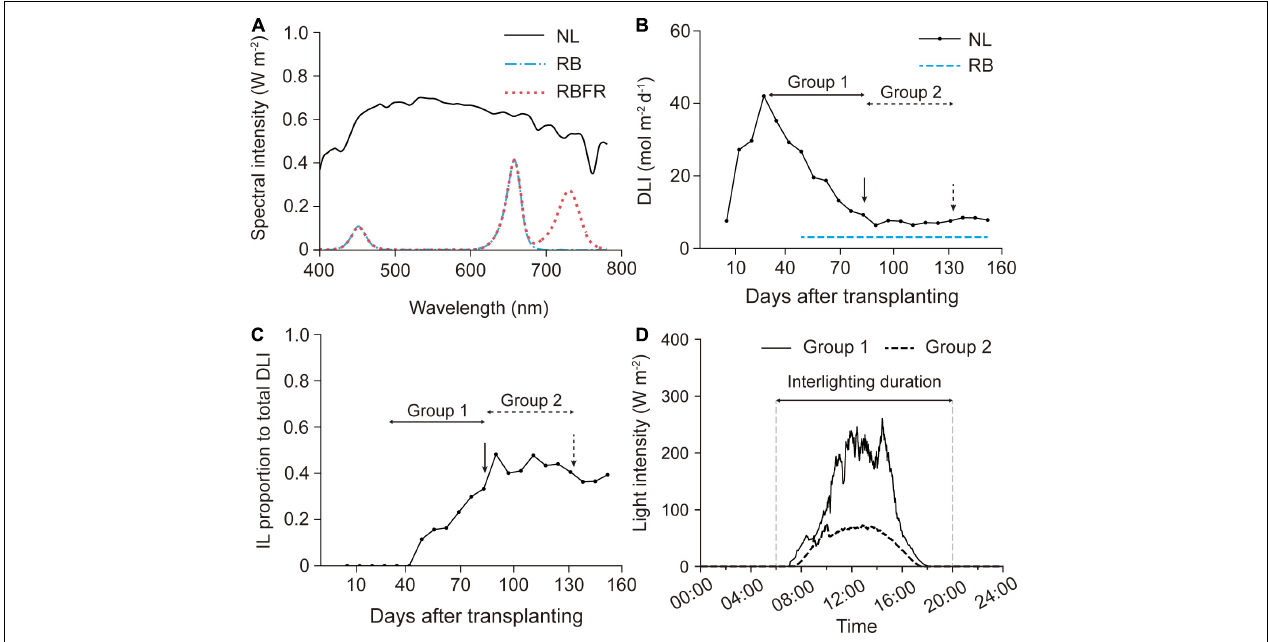
FIGURE 1 | Light environment in the greenhouse during cultivation: spectral composition (A) , weekly average of the day light integral (DLI) (B) , interlighting (IL) proportion to total DLI (V) (C) , and averaged daily light intensity (D) . NL, RB, and RBFR mean natural light, NL with red + blue LED interlighting, and RB with far-red light,